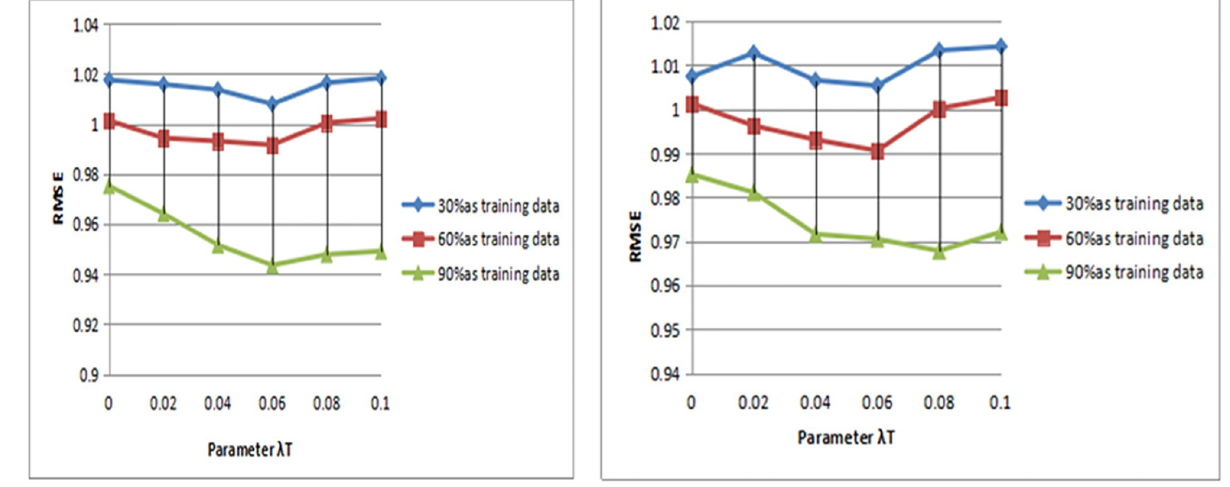
Fig 7. Parameter analysis of